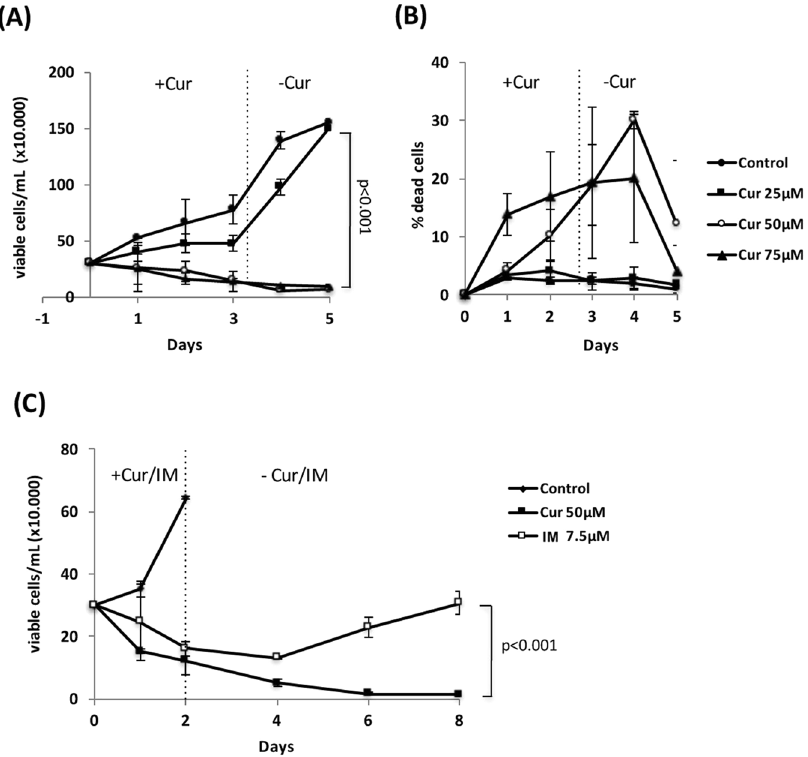
Figure 2. Effects of curcumin and imatinib on the proliferation of K562 cells in vitro . ( A , B ) K562 cells (3 × 10 5 cells/mL) were cultured in the presence of curcumin (0, 25, 50, and 75 μ M) for 3 days, and curcumin was then removed from the medium. Cells were enumerated every day using the trypan blue staining method. Results for viable ( A ) and dead ( B ) cells are shown. ( C ) K562 cells were cultured in the presence of curcumin (50 μ M) and imatinib (IM, 7.5 μ M) for 2 days, and the compounds were then removed from the medium. Cells were enumerated at the indicated times. The results are the average of three independent experiments (means ±